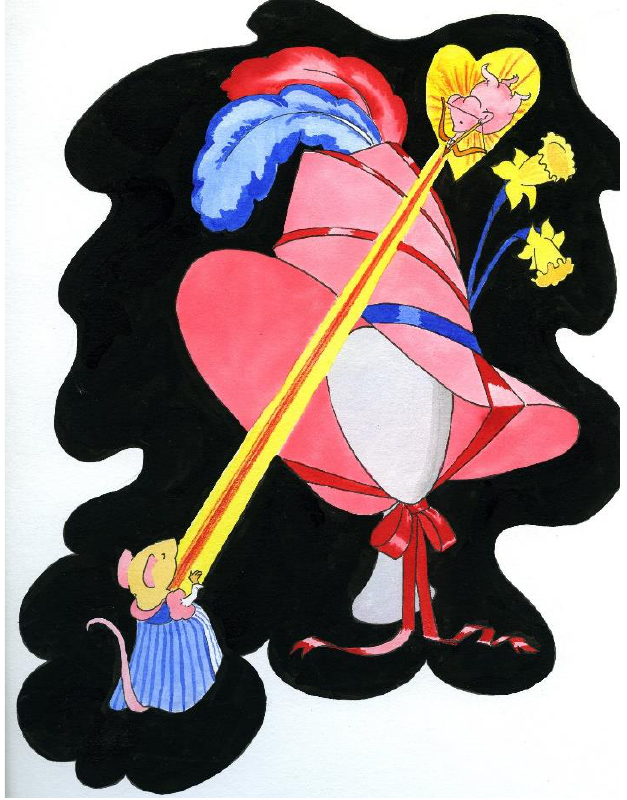
Figure 5. McMaster’s illustration for The Beautifull Cassandra (Austen 2021), p.